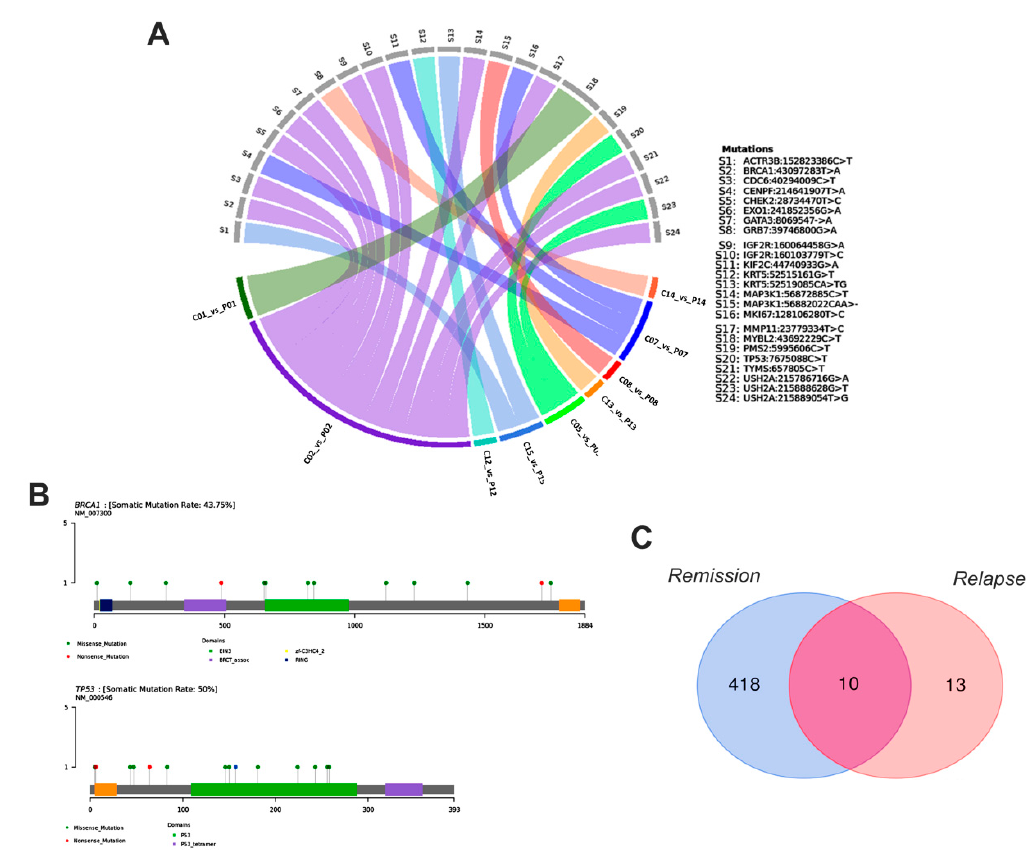
Figure 7. Gene variants shared by tumor fragments and plasma samples of women with BC. ( A ) Circos plot depicting the correlation between fragment and plasma shared samples and gene variants in patients. ( B ) Gene map of the somatic mutation in BRCA and TP53 genes. ( C ) Total variants detected during remission and relapse of the disease. Graphics were generated from the R language, using the VennDiagram, circlize, dplyr and reshape2 packages.